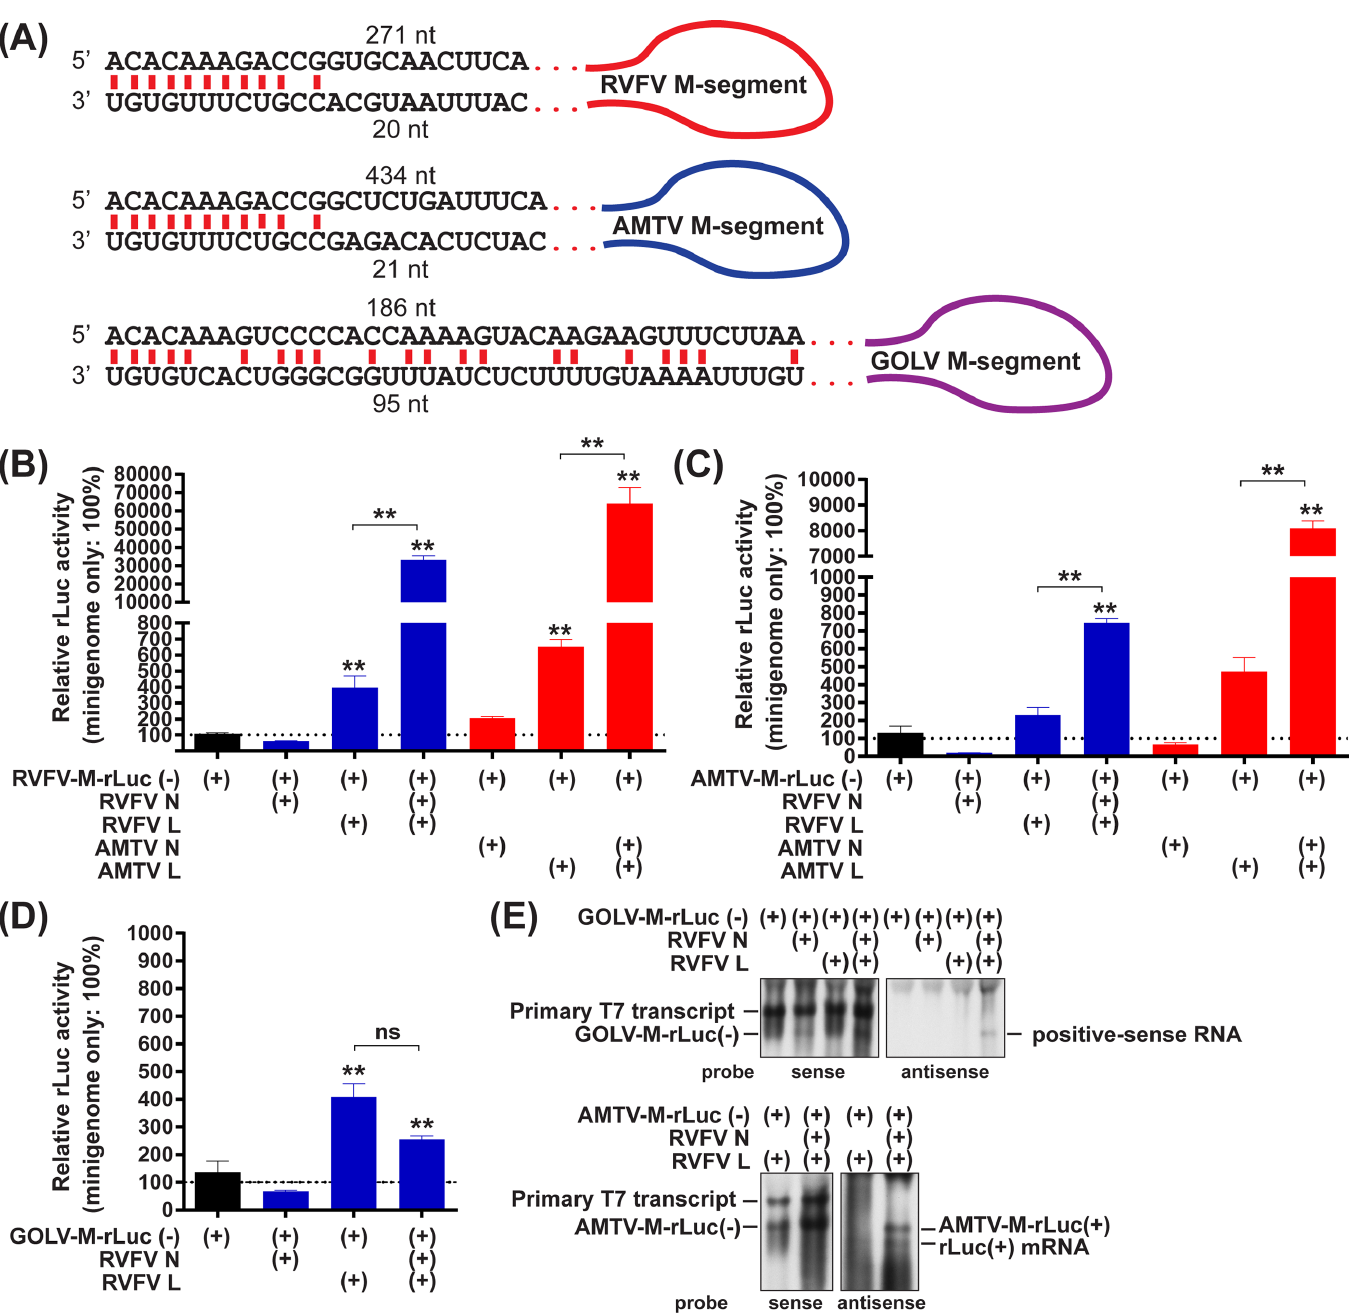
Fig 1. Replication of the M-segment minigenomes of Rift Valley fever phlebovirus (RVFV), Arumowot virus (AMTV), and Gouleako goukovirus (GOLV) in relation to co-expression of RVFV N and L proteins. (A) Schematics of panhandle sequenceof M-segmentsof RVFV, AMTV, and GOLV. (B– D) BHK/T7-9 cells were transfected with plasmidsexpressingthe RVFV-M-rLuc(-) (M-segment minigenome RNA of RVFV) (B), AMTV-M-rLuc(-) (M-segment minigenome RNA of AMTV) (C), or GOLV-M-rLuc(-) (M-segment minigenome RNA of GOLV) (D), and those expressingN and/or L proteins derivedfrom either RVFV or AMTV. The ratio of Renilla luciferase(rLuc) activities to firefly luciferase (fLuc) activitiesderived from pT7-IRES-fLuc (control plasmid) was shown as percentage: i.e., the same type of minigenome without N and L expressionwas set as 100%. Bars represent means plus standarderrors. Asterisks on error bars represent statistically significantincreasescomparedto samples expressingminigenome only (One-way ANOVA ** p < 0.01). Samples expressingminigenome, N proteins, and L proteins were also statistically comparedwith those expressingminigenome, and L proteins. ns, not significant.(E) Northernblot using total RNA derivedfrom the GOLV minigenome assay (top panels) or AMTV minigenome assay (bottom panels). Sense rLuc probe (left panels) and antisenserLuc probe (right panels)were utilized.